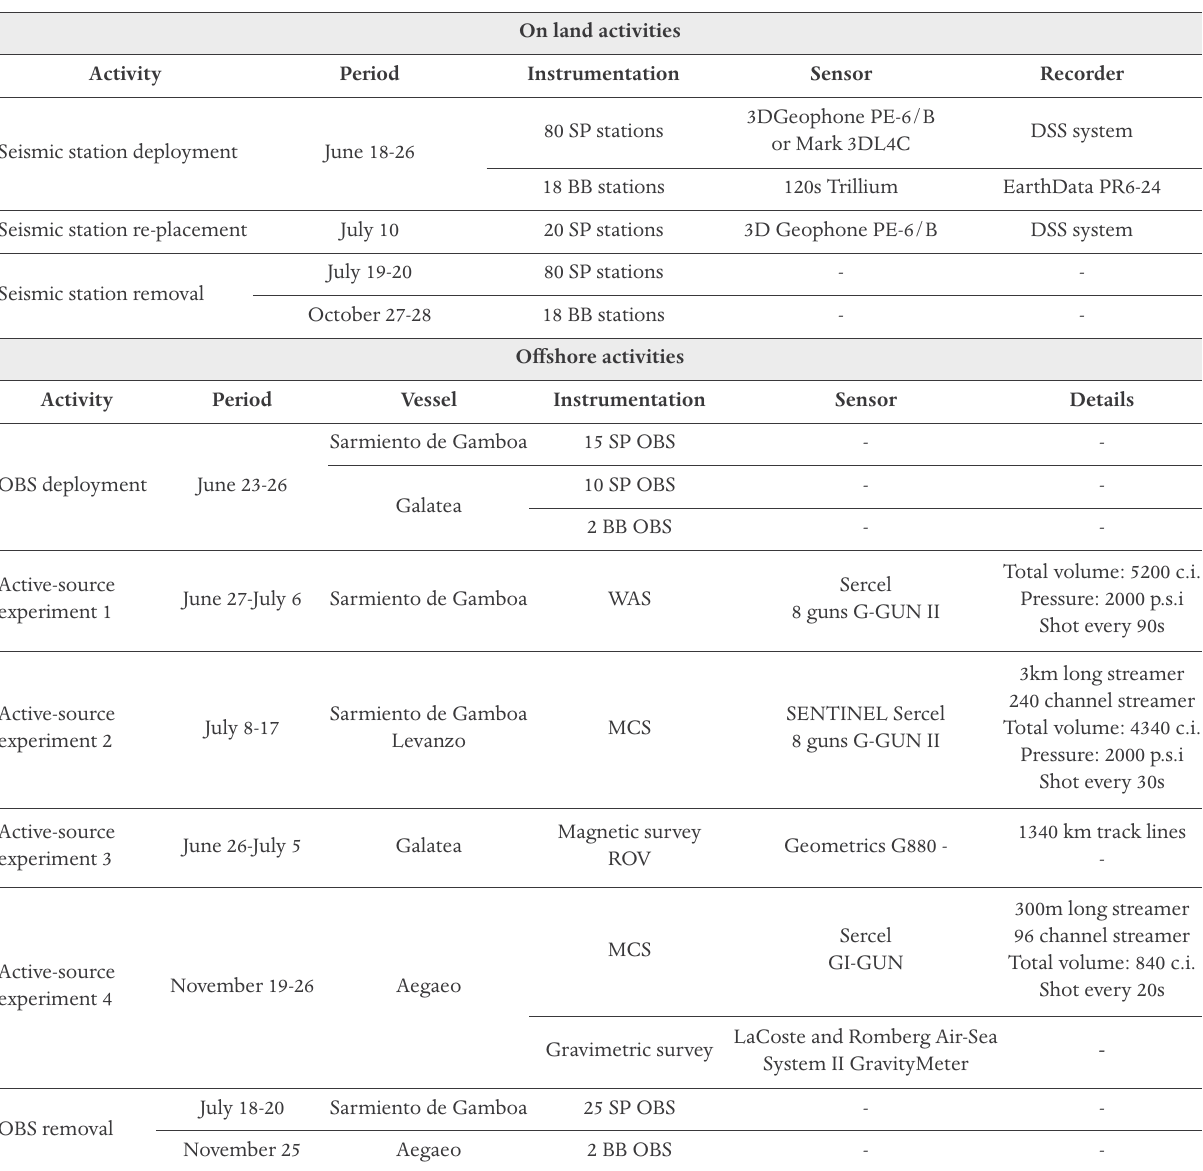
Table 1. Technical details of TOMO-ETNA experiment activities (SP, short period; BB, broadband; OBS, ocean bottom seismometer; WAS, wide angle seismic; MCS, multi-channel seismic; ROV, remotely operated